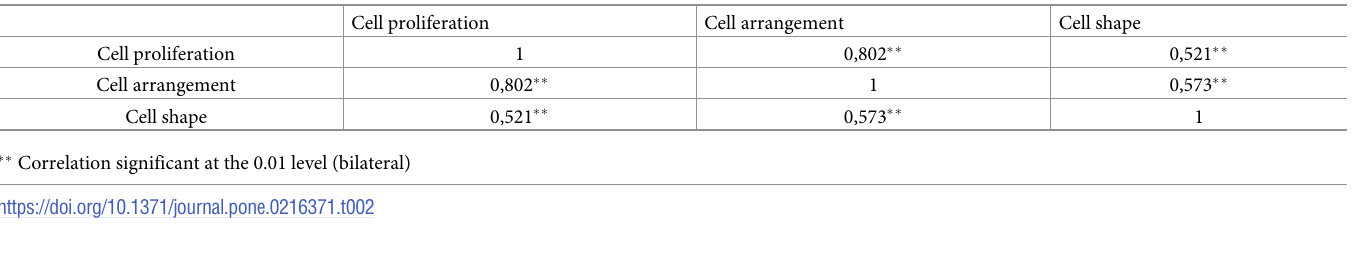
graft compatibility in F apricot cross was similar to that for other agronomic traits such as 1 fruit quality related characters (ripening time, skin color) or reproductive phenology [44–46]. The establishment of correlations between anatomical traits may reduce the number of characters for screening genotypes or progenies for graft compatibility. It helps to optimize time and labor required for evaluation of a high number of grafts per individuals in segregating crosses. Based on results presented here, we recommend using our phenotyping approach for phenotyping graft compatibility in other fruit and forest trees. Thus, we propose an earlier ana- tomical test for evaluation of compatibility between variety industrial rootstocks and new culti- vars released to market.